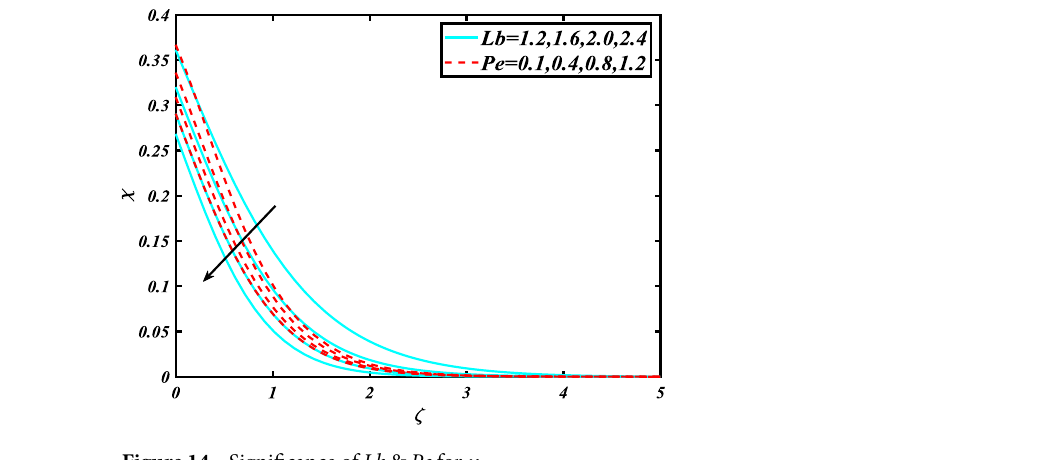
Figure 14. Significance of Lb & Pe for χ .